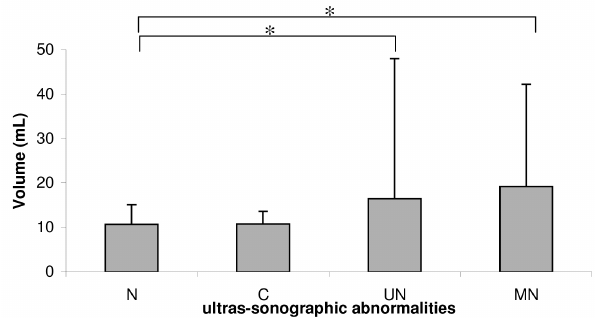
Figure 2 - Thyroid volume compared with different ultrasonographic find- ings. N: no abnormality; C: cysts; UN: single nodule; and MN: multinodular goiter. Note that patients with thyroid nodules had a significantly increased thyroid volume (* p<0.01)